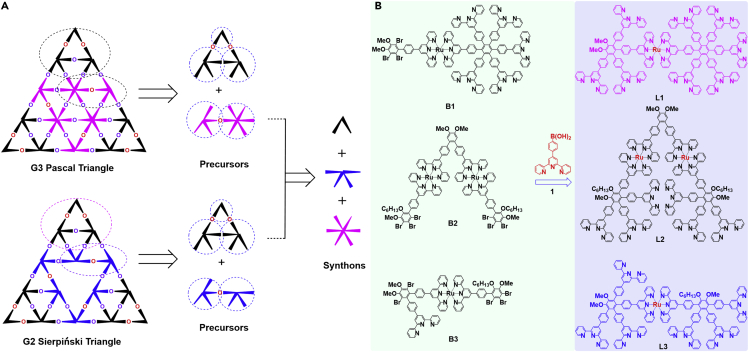
Retrosynthetic Analysis and Ligands Synthesis(A) Illustrating the disconnection of G3 PT and G2 ST to three precursors and three simplified synthons by the retrosynthetic analysis.(B) Synthesis of modular Metallo-organic Ligands through a multi-fold Pd0-catalyzed Suzuki coupling reaction on Ru-complexes. Reagents and conditions: CH3CN, Pd(PPh3)4, K2CO3, reflux.